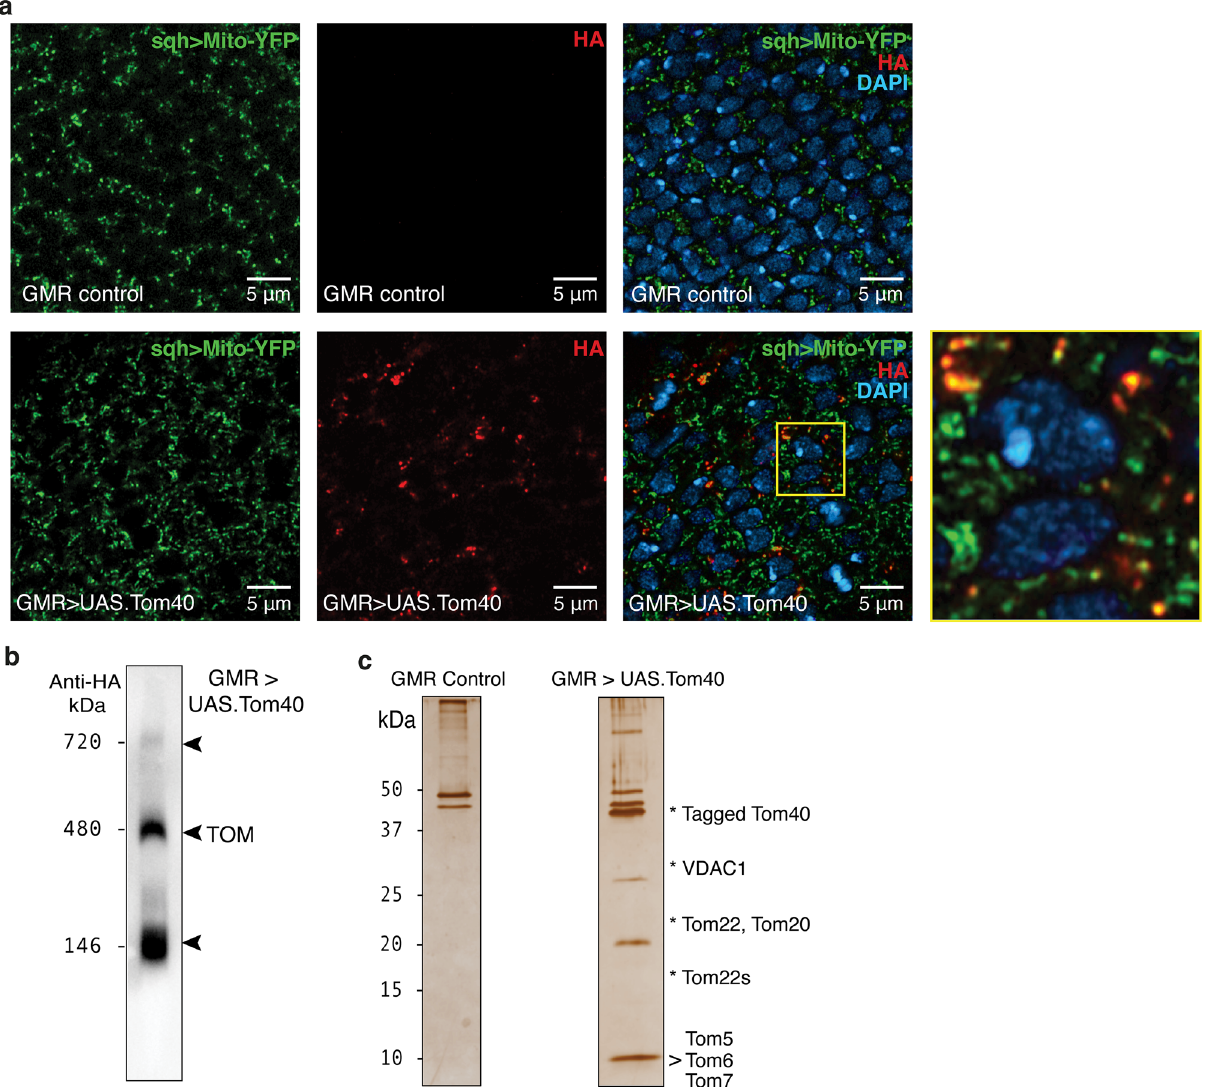
Figure 3. Subcellular localisation and assembly of Tom40. ( a ) Sub-cellular localisation of UAS.Tom40 . All panels show imaginal eye discs from third instar Drosophila larvae expressing mitochondrially-targeted YFP (sqh > mito-YFP; green). The upper panels show sections from GMR-GAL4 (driver-only) control flies, while the lower panels are from flies co-expressing GMR-GAL4 > UAS.Tom40 (HA antibody; red). An enlargement of the boxed area, in flies expressing UAS.Tom40 , is shown immediately to the right. ( b ) BN-PAGE of membranes from GMR-driven Tom40-expressing eyes. Western blot analysis against a HA epitope tag reveals that Tom40 assembles into a higher order complex of nominal mass ~ 480 kDa. Additional bands migrating close to 146 kDa and 720 kDa markers indicate the presence of other Tom40-containing complexes. ( c ) Silver-stained SDS-PAGE showing affinity-purified (anti-FLAG) Tom40 samples from eye membranes solubilised with digitonin. Each sample corresponds to protein derived from ~ 800 fly heads and is representative of at least three independent samples. Affinity purified products from flies reared at 25 °C, carrying GMR only (non-specific binding control) or GMR > UAS.Tom40